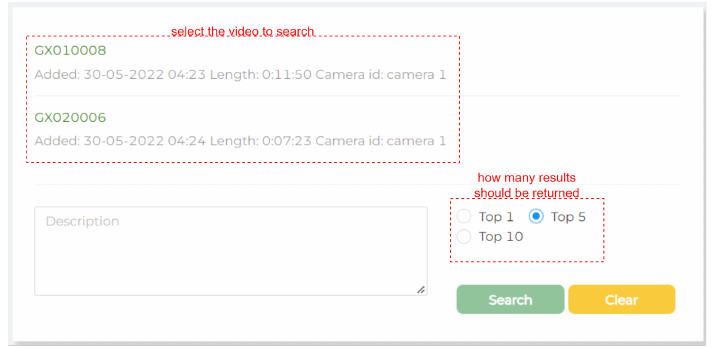
Figure 4. A screenshot of the web interface for fast person description search. The user selects the video to perform the search from a list (shown are two videos with names GX010008 and GX020006) and types the search description in the text box. At the bottom right, they can select the desired k value. The search result appears on the bottom part of the screen below this